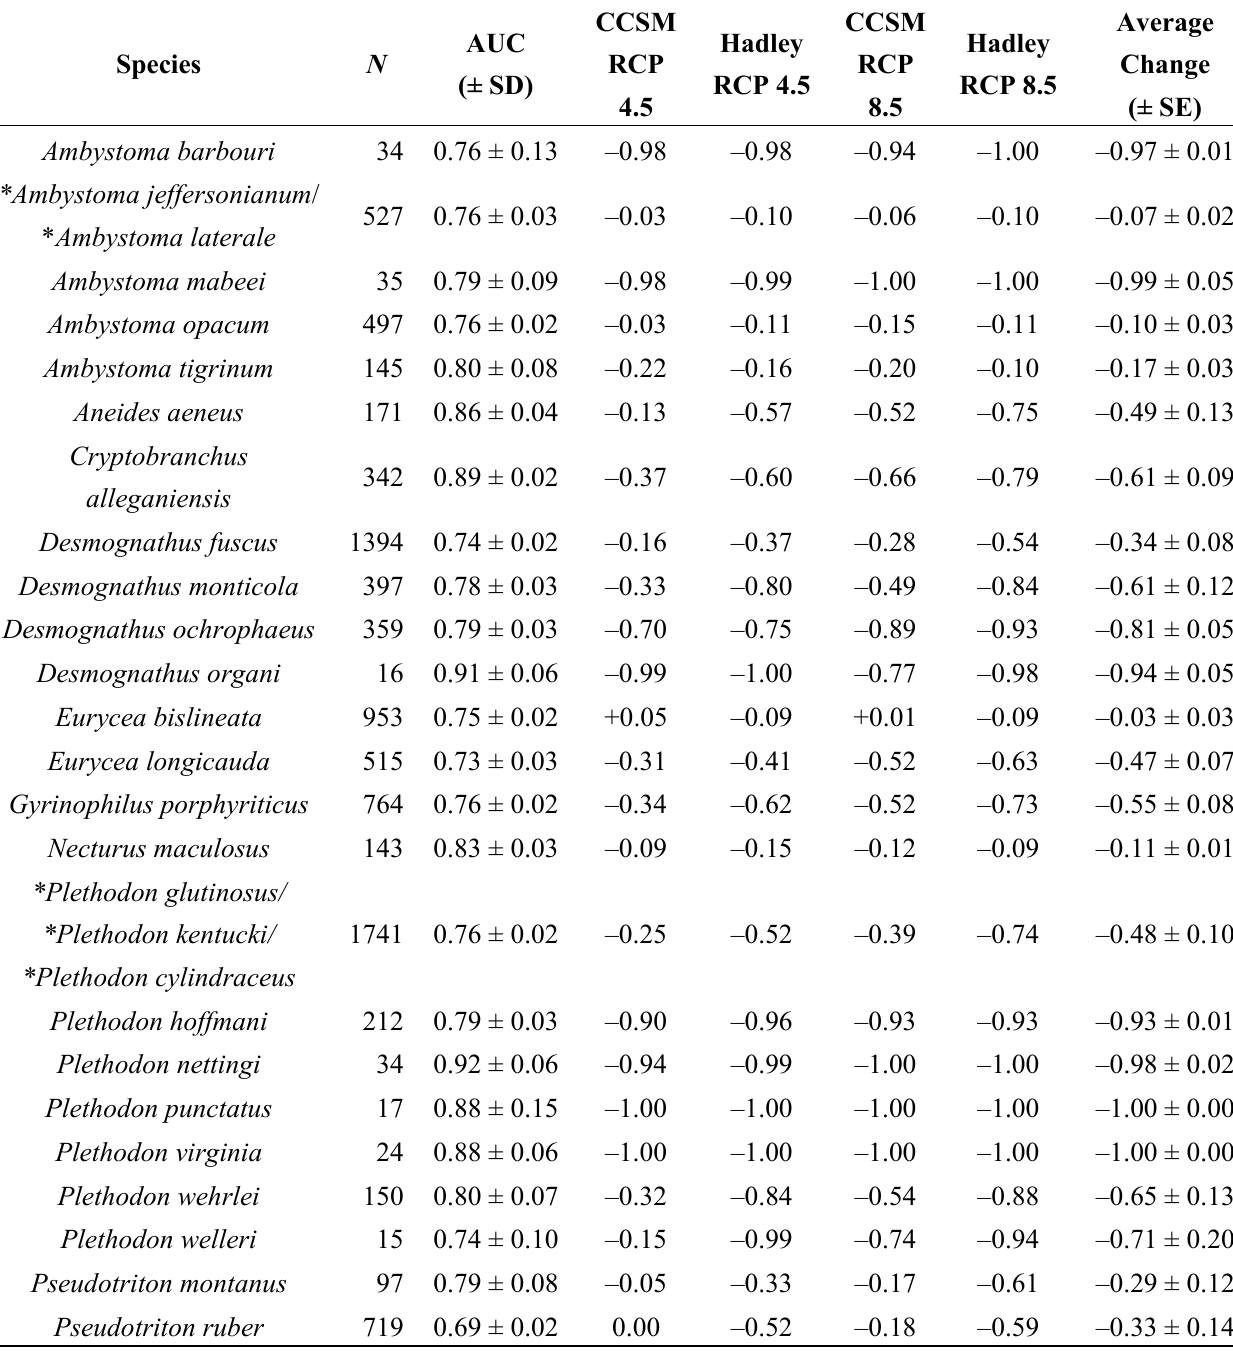
Table 5. Projected proportional change between the current climatic niche and the 2050 projected climatic niche for priority salamander species (Table 3) in the northeastern U.S. We report average percent suitable climate niche based on current and projected climate scenarios (CCSM4 (CCSM) and HADGEM2-CC (Hadley)) under two Representative Concentration Pathway (RCP) scenarios (RCP 4.5 and RCP